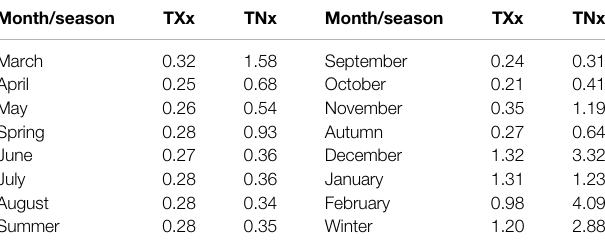
TABLE 6 | Monthly and seasonal DISO for TXx and TNx over